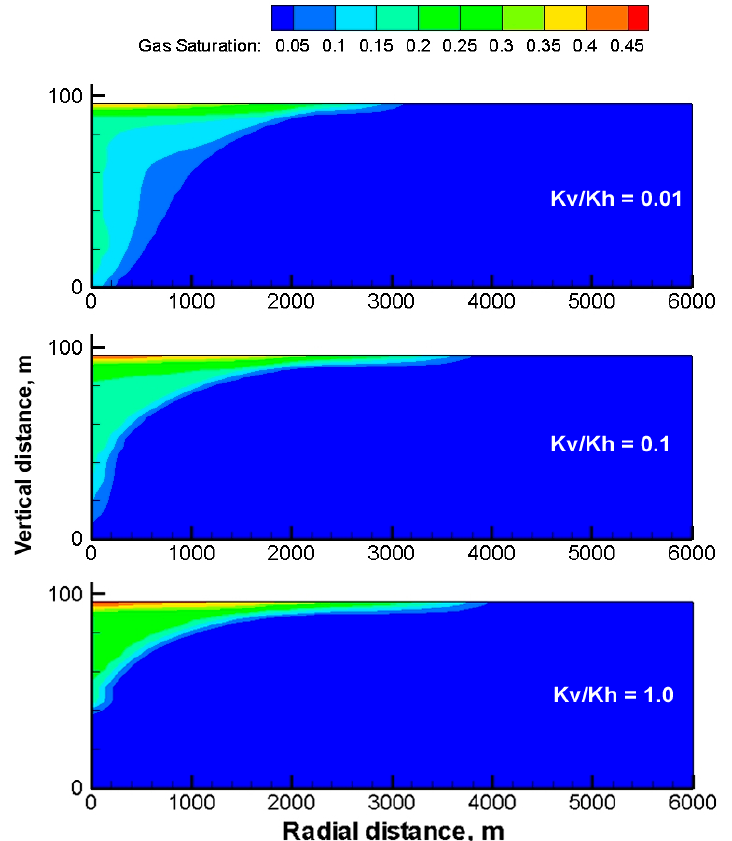
Figure 10. The impact of the vertical/horizontal permeability ratio on CO 2 distribution after 500 years in a homogeneous domain. Cases 8, 9 and 10 in Table 3.